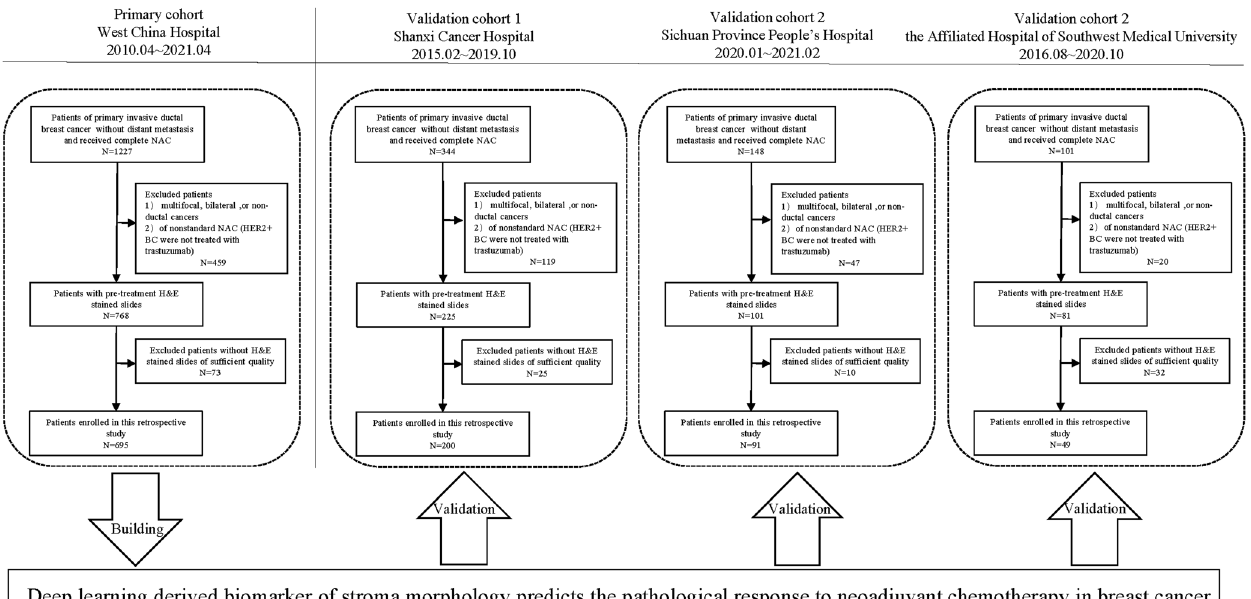
Fig. 1 Patients recruitment and study design. 1035 patients out of 1820 with pretreatment H&E stained slides from four Chinese hospitals were included in this study for stroma-derived biomarker development and